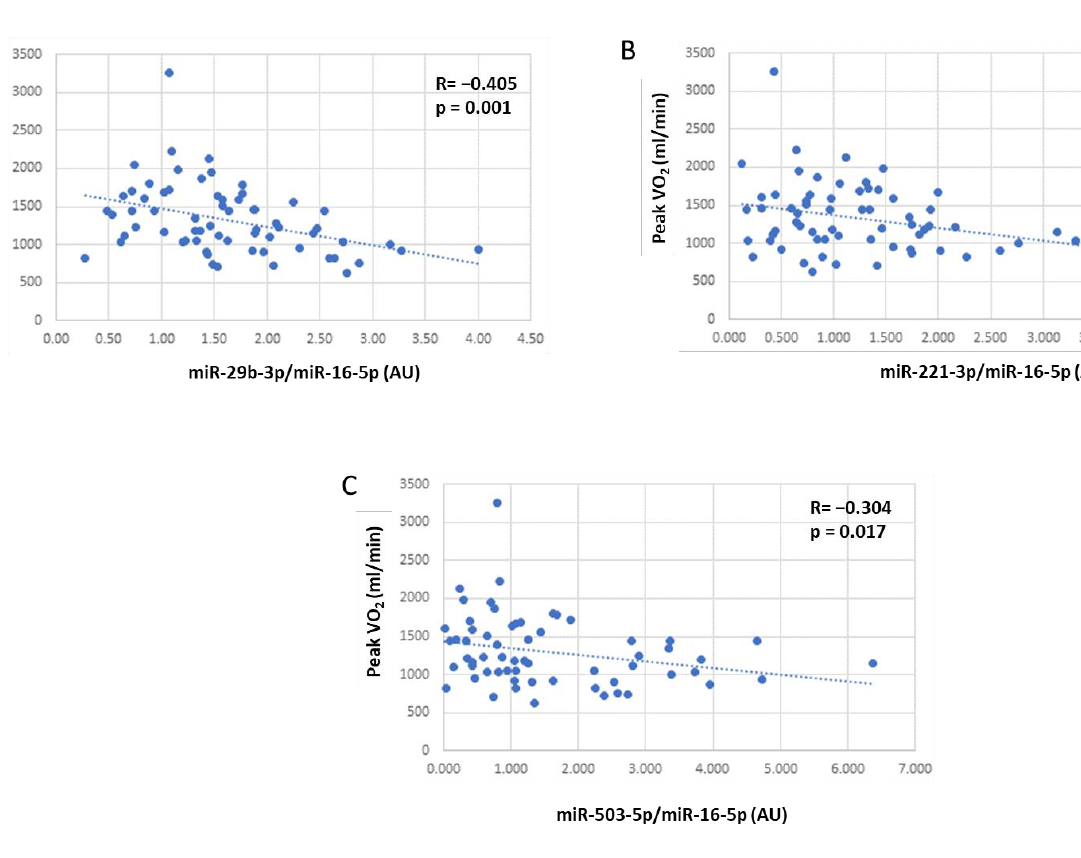
Figure 1. Correlation of ( A ) miR-29b-3p, ( B ) miR-221-3p, and ( C ) miR-503-5p with peak VO 2 at baseline (n = 69 HF patients). miRNA levels are expressed as arbitrary units (AU) calculated with the delta-delta Ct method, using miR-16-5p as a housekeeping gene.